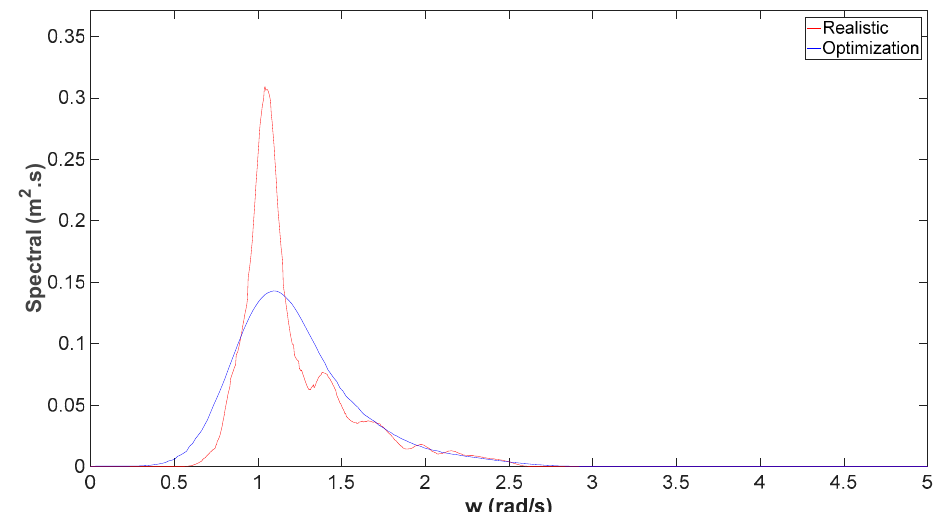
Figure 17. Spectral density of the wave resource used for the optimization of the controllers (blue line) and for the realistic simulation (red line).